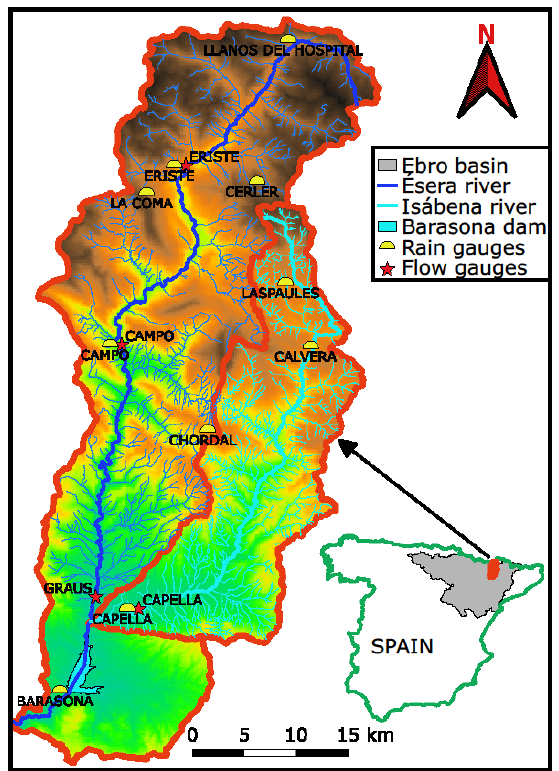
Figure 1. Ésera River catchment. Figure 1. É sera River catchment. Water 2020 , 04 , x FOR PEER REVIEW